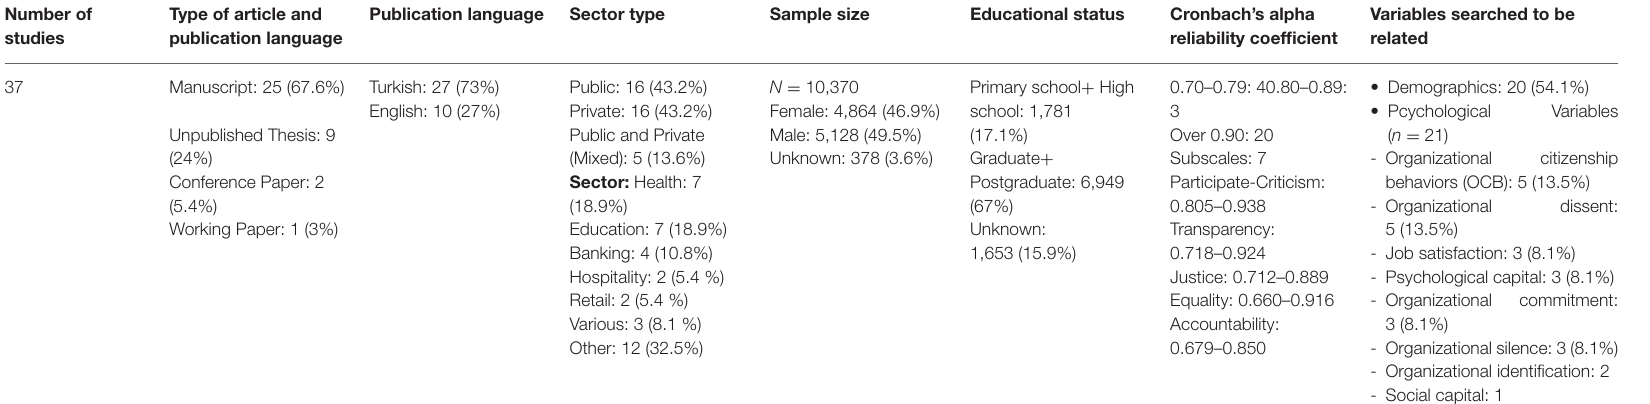
TABLE 3 | The characteristics of the studies included in focused systematic